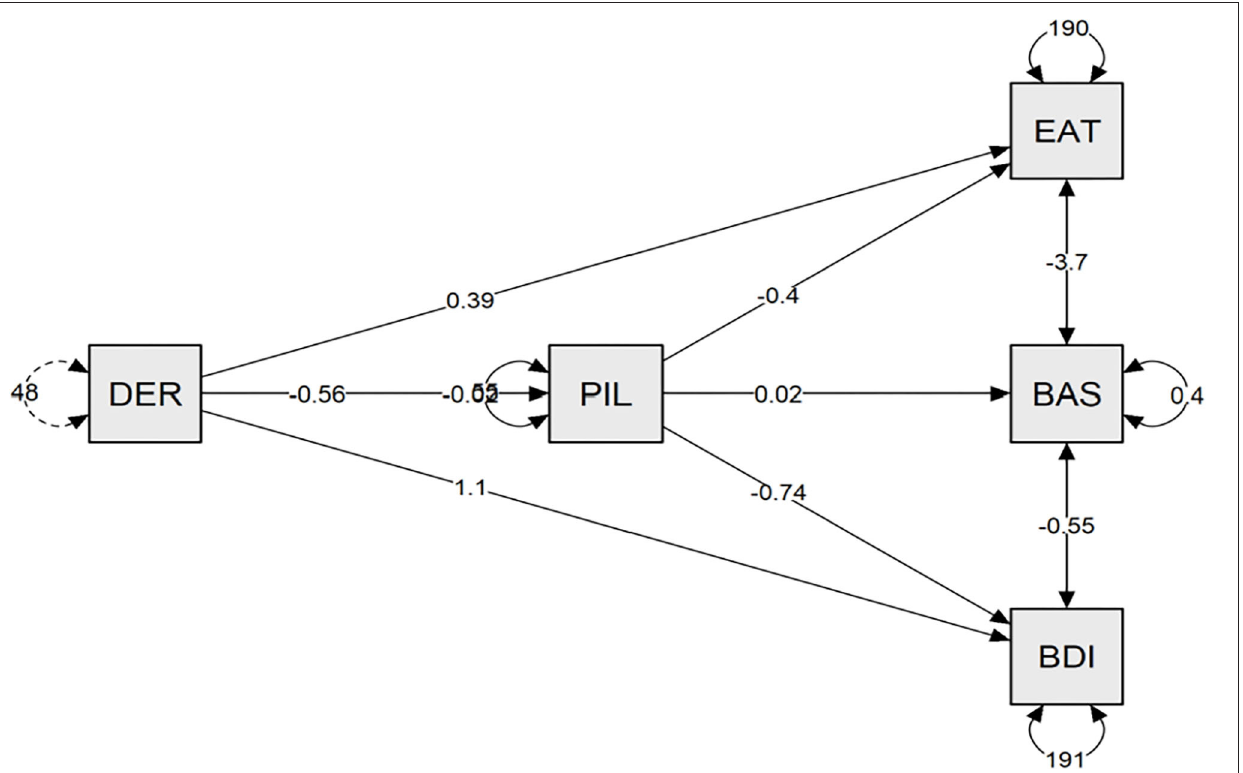
FIGURE 1 | The meaning in life is a mediating variable between the emotional deregulation and binge eating disorder psychopathology, and depression in young adult women without eating disorders. DER, emotional deregulation; PIL, purpose in life; BDI, Beck Depression Inventory; BAS, body area satisfaction.